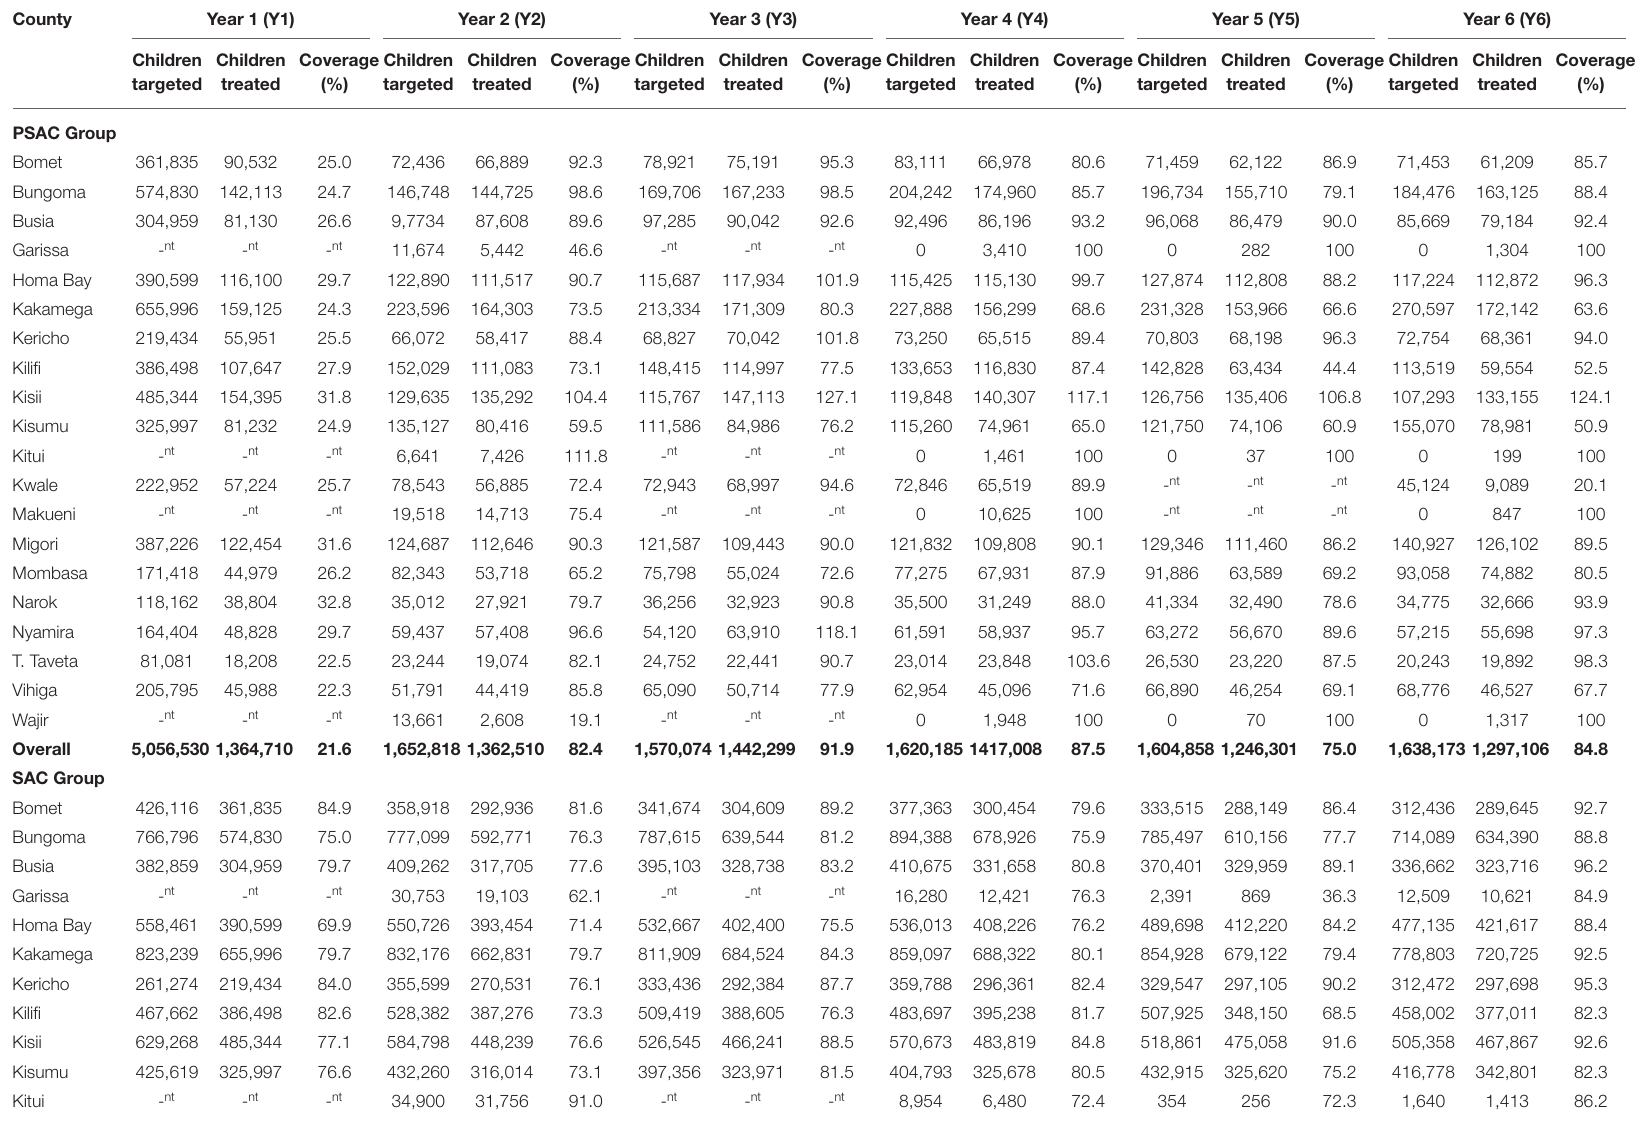
TABLE 2 | County level summary of STH treatment coverage (%) for preschool (PSAC) and school (SAC) aged group of children in 20 counties in Kenya.